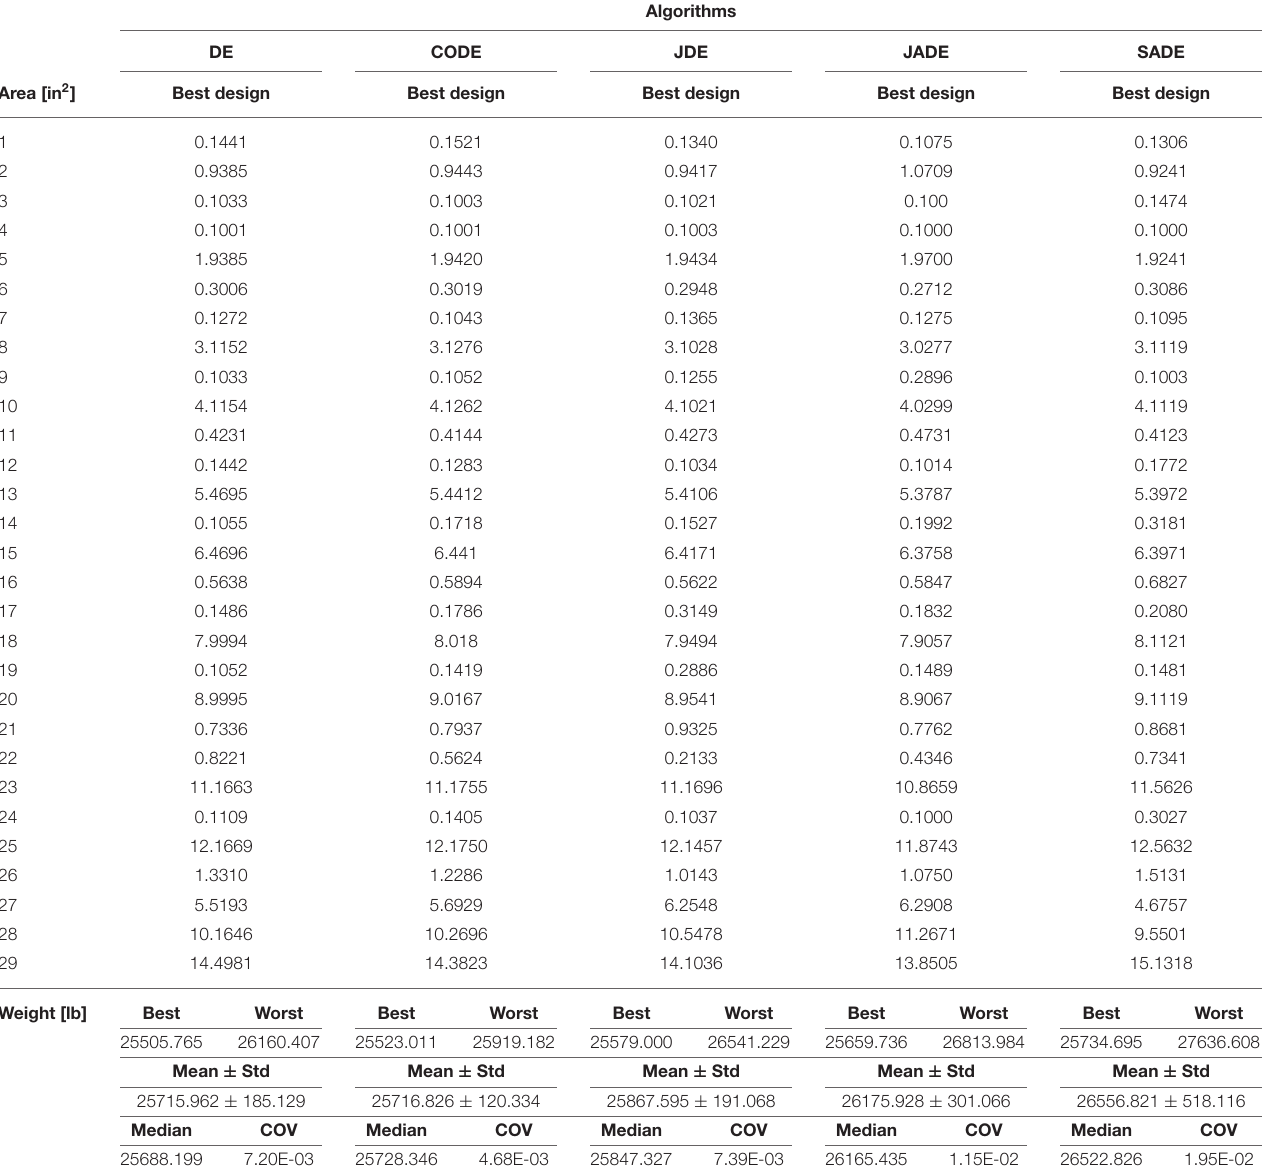
TABLE 9 | Algorithms’ statistical parameters for the 200-bar plane truss problem.